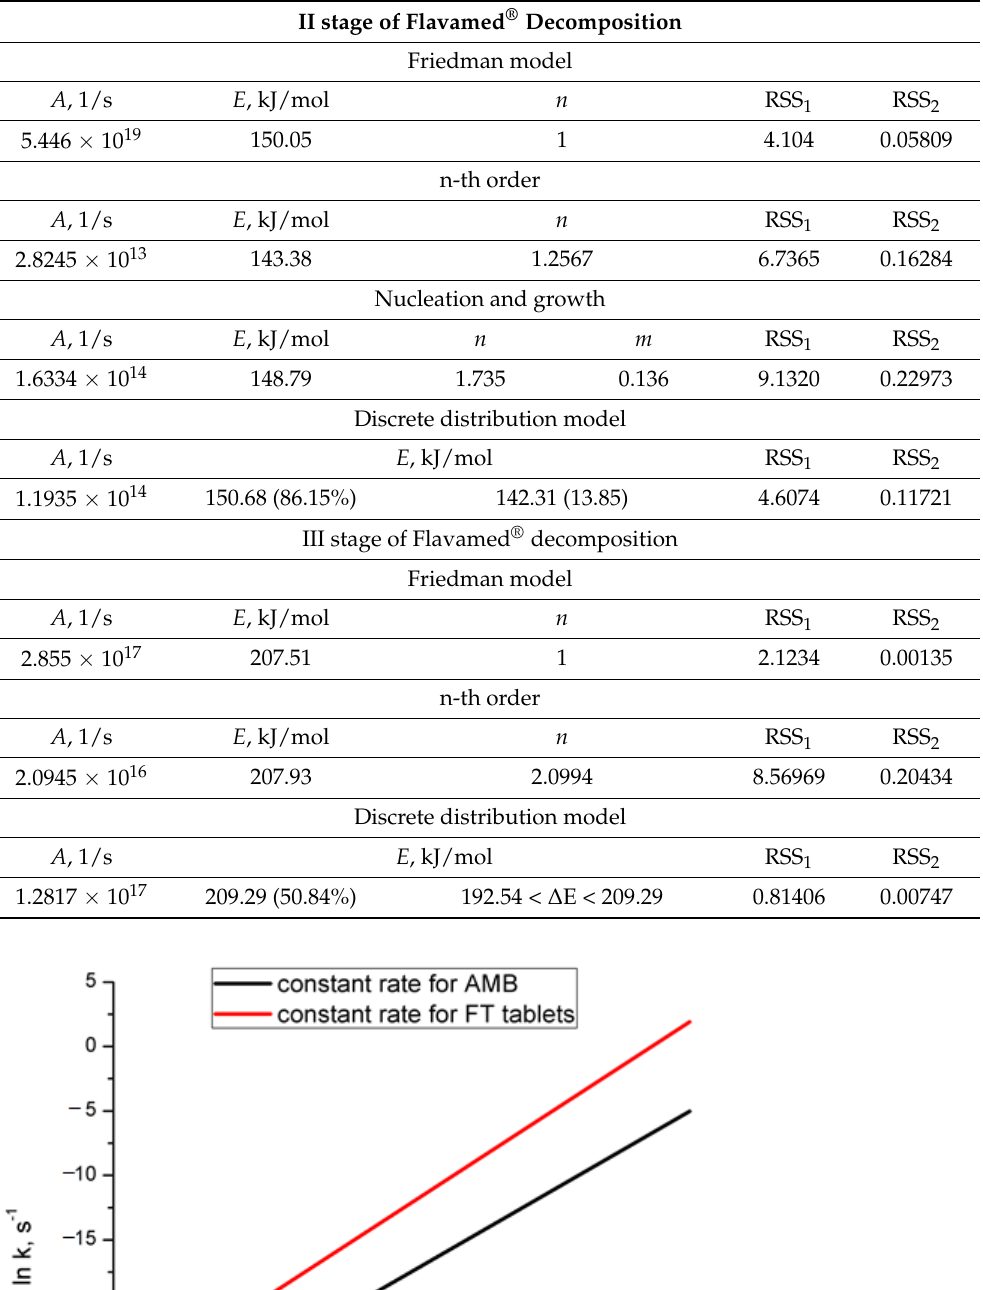
Table 3. The isoconversional and model-fitting kinetic analysis of FT formulation thermal decompo- sition: II stage (upper/first table) and III stage (down/second table).